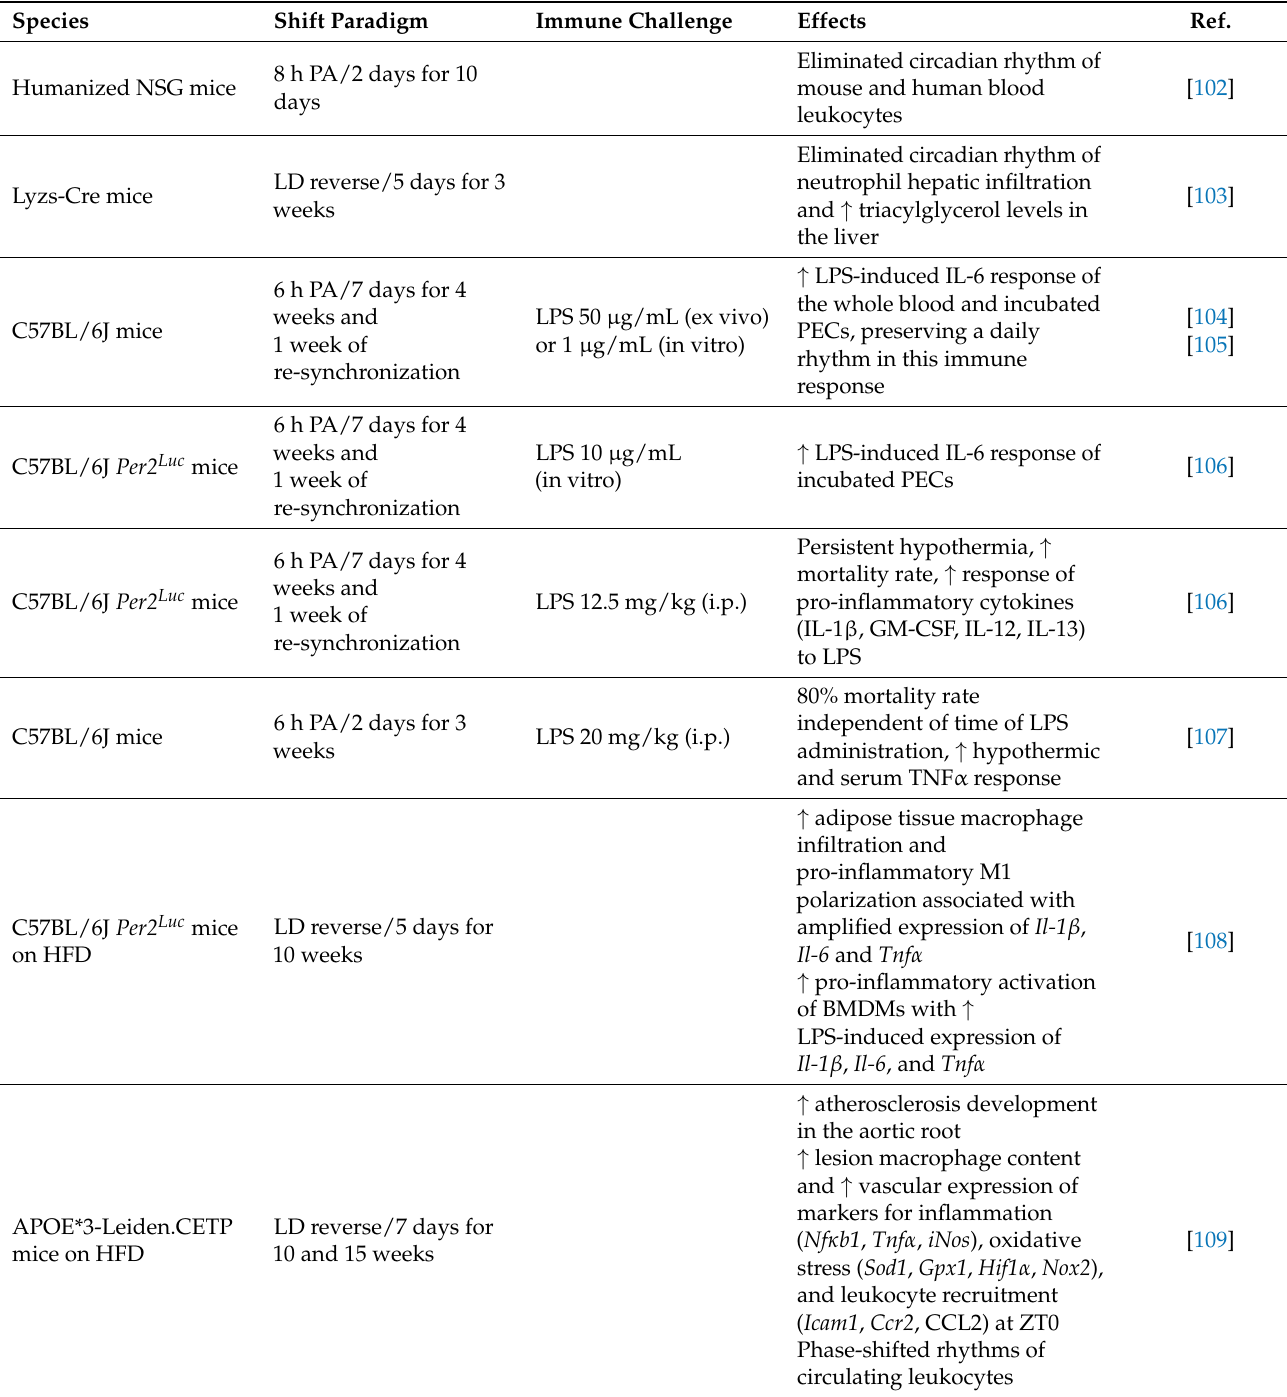
Table 2. The effects of different light-phase shift paradigms on the immune parameters and functions under the steady state and challenged conditions in